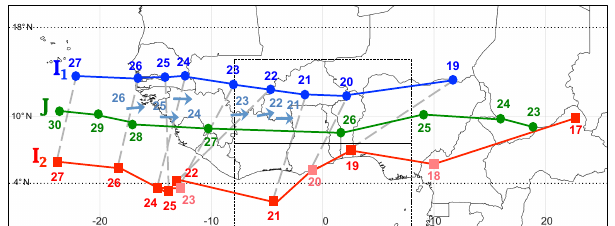
Figure 16. Significant synoptic-scale features during 17–30 July 2016 (end of Phases 2–4). To create this graph, vortices were sub- jectively identified in 850hPa streamlines based on operational ECMWF analyses. All vortex positions refer to 00:00UTC with the date given as numbers. Round symbols mark cyclonic systems (la- belled I 1 and J), squares anticyclonic systems (labelled I 2 ). Paler colours are used for days when the vortices were not clearly iden- tifiable. Vortices with a joint propagation are linked with dashed grey lines. The cores of significant 850hPa jets are indicated with light blue arrows, again with the dates at 00:00UTC given as num- bers. The boxes mark the areas used to compute the NSPD shown in Fig. 5a. The stippled lines show the latitude range used to produce Fig.